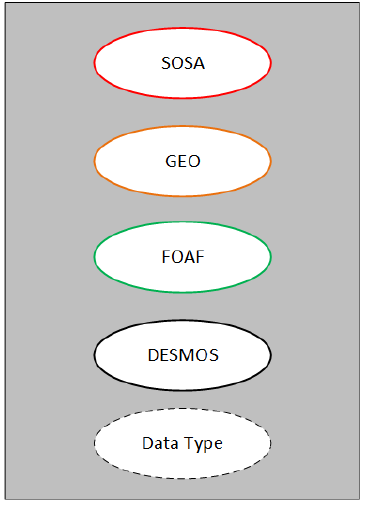
Figure 7. Primary ontologies in